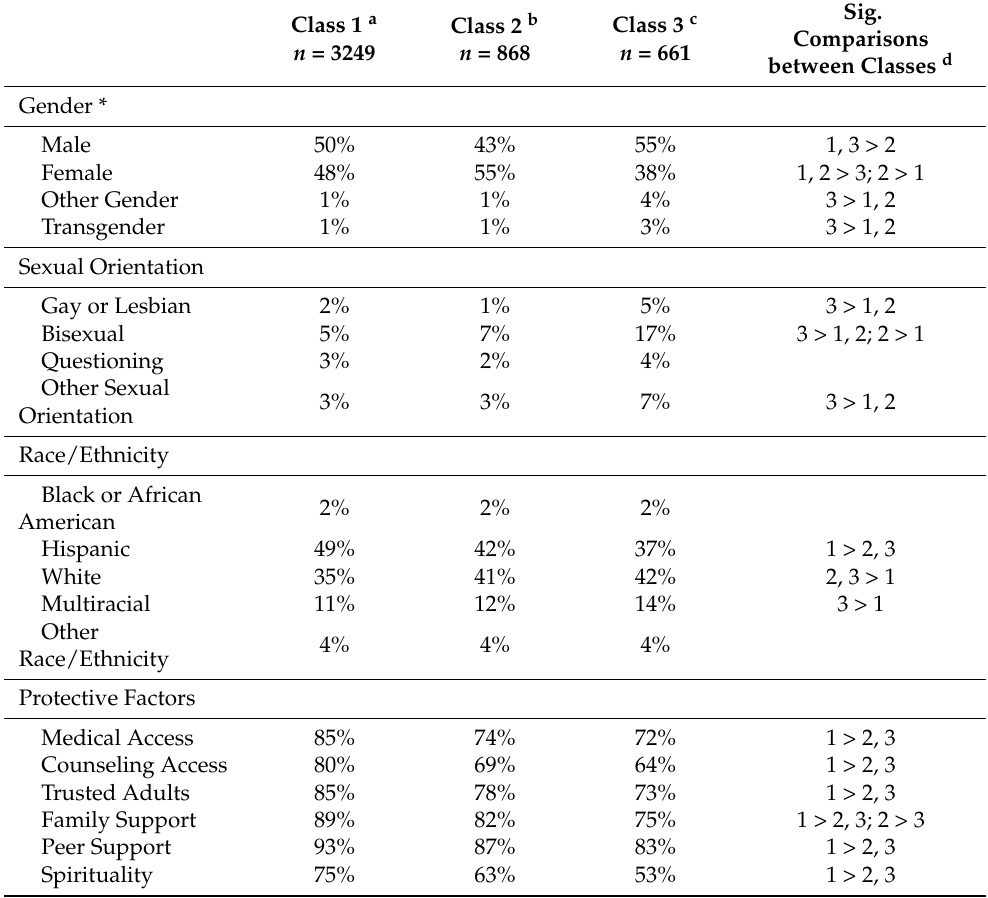
Table 6. Percentage of Participants Classified in each Class According to Gender, Sexual Orientation, Race/Ethnicity, and Prevalence of the Protective Factors.